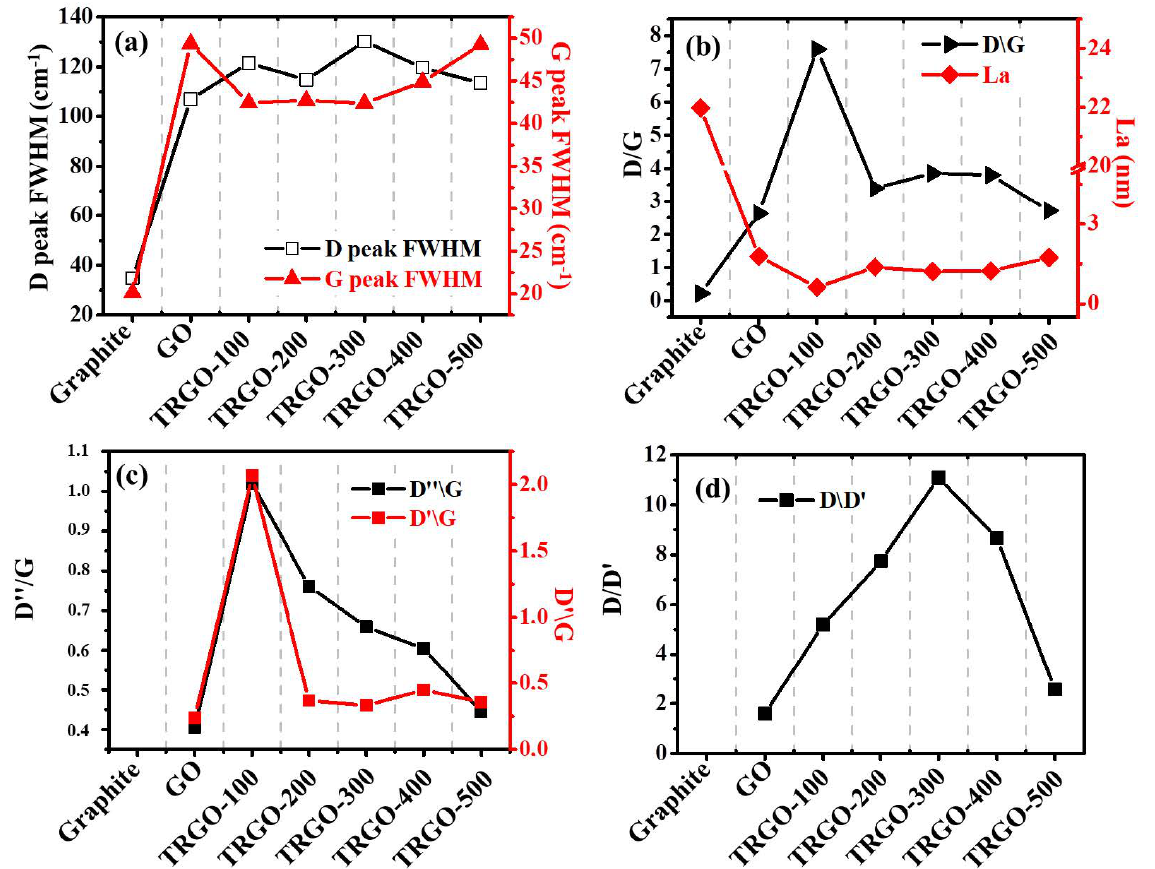
Figure 6. The ( a ) D- and G-peak FWHM, ( b ) D/G and La, ( c ) D′′/G and ( d ) D/D′ as a function of graphite, GO, and TRGO-100 to TRGO-500.